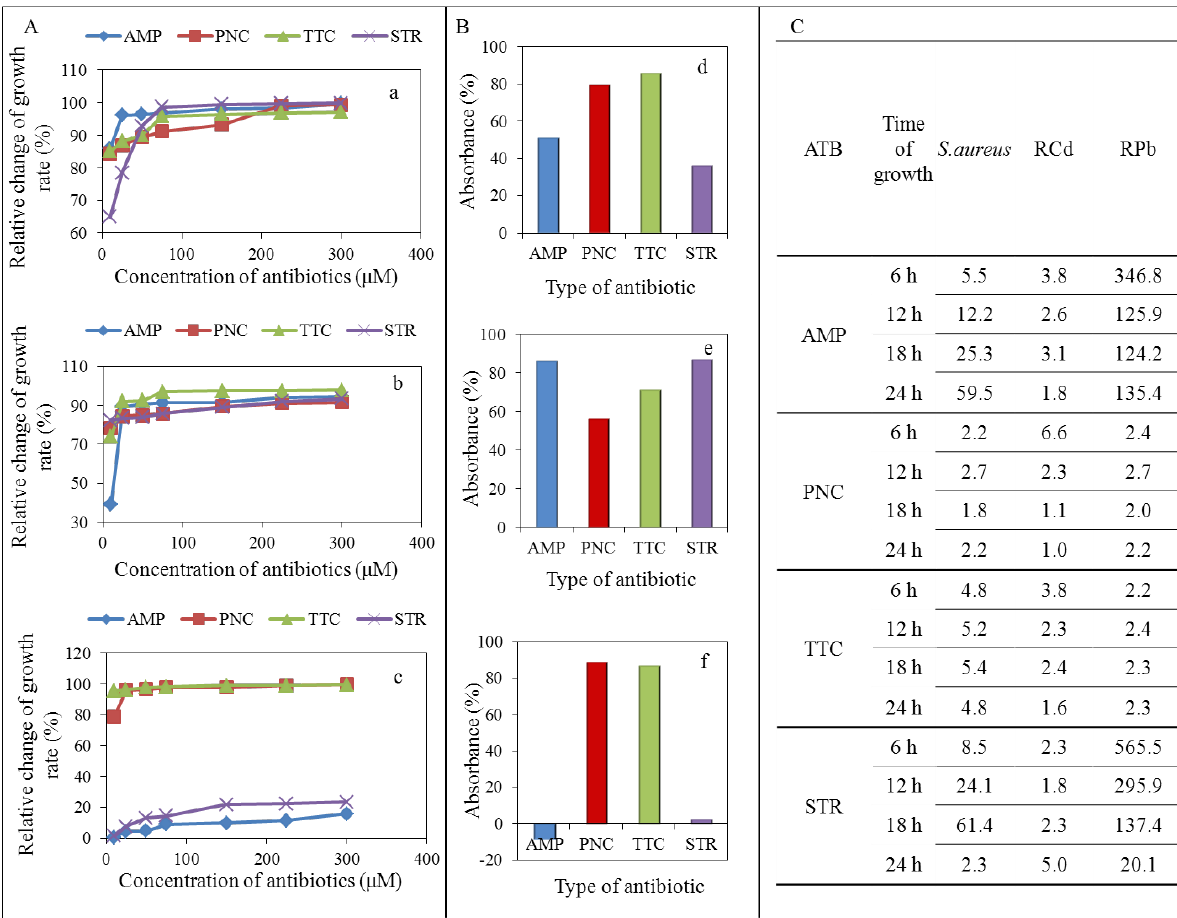
Figure 2. Spectrophotometric analysis of wild type S. aureus or S. aureus strains resistant to 950 µM concentration of heavy metal ions after application of various concentration of antibiotics (0, 10, 25, 50, 75, 150, 225 and 300 µM): ( A ) Relative change of growth rate as the relative difference between S. aureus strain without antibiotic and individual dose of antibiotic (related to the value obtained without antibiotic) in first 6 h of measurement in strains of S. aureus (%): ( a ) non-resistant S. aureus ; ( b ) RCd; ( c ) RPb. ( B ) The cumulative effect of different types of antibiotics (%) on: ( d ) non-resistant S. aureus ; ( e ) RCd; ( f ) RPb. All values were deducted from the non-resistant S. aureus (100%). ( C )